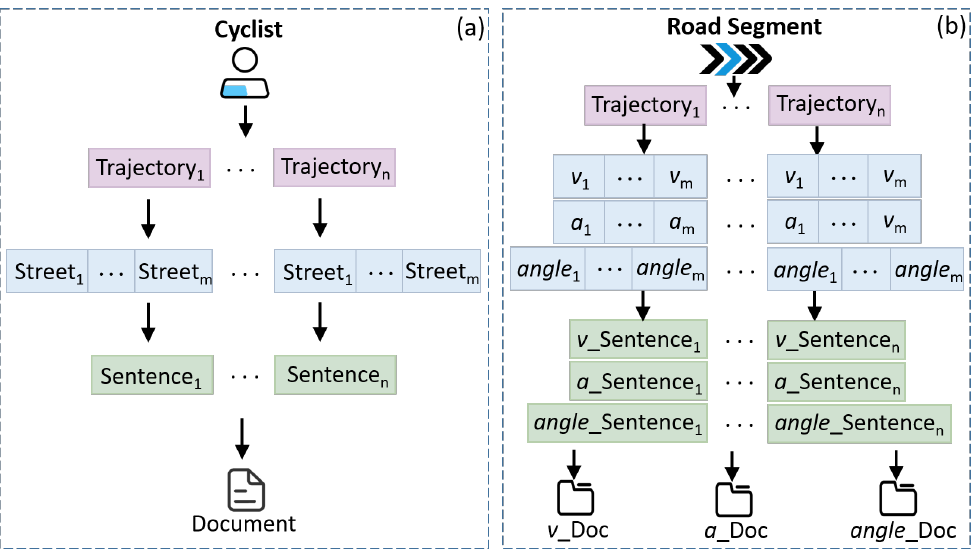
Figure 3. The processes of trajectory data transformation. ( a ) Textualization for trajectories to street names. ( b ) Textualization for moving